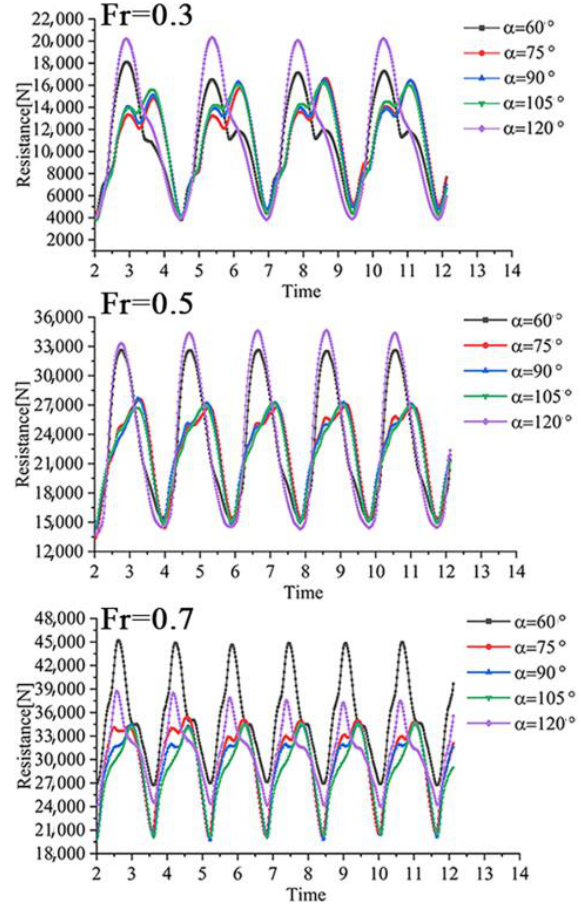
Figure 12. Time course diagram of total drag variation at three speeds for a pentamaran (λ/L =